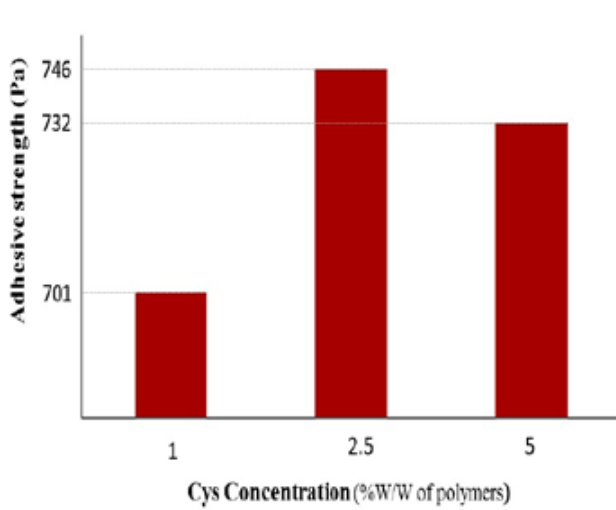
FIGURE 7 - Adhesion strength of nanofibrous mats versus various concentrations of Cys.